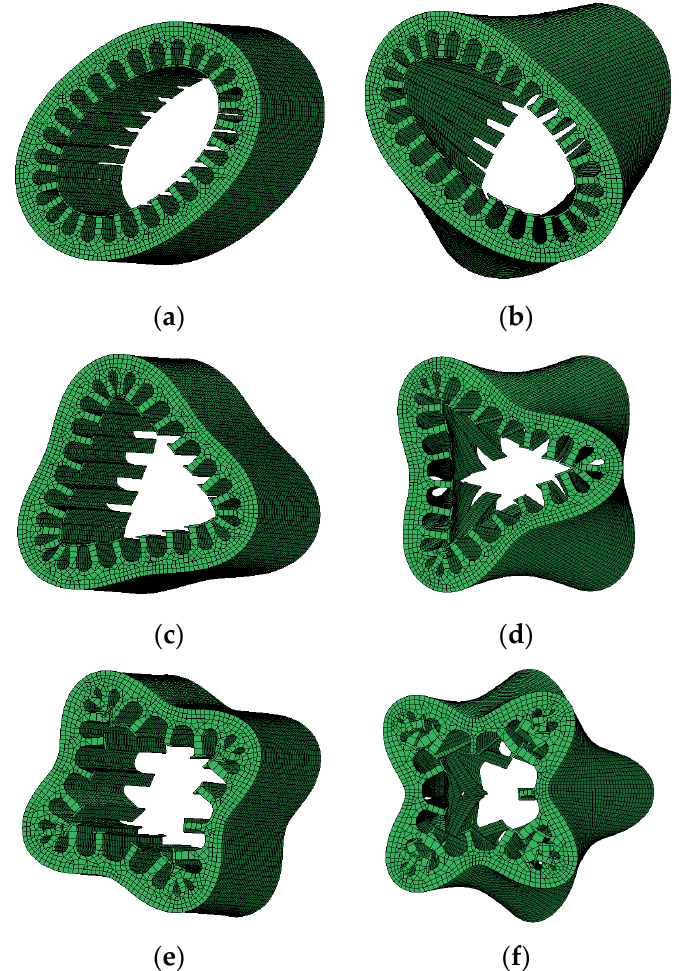
Figure 1. Normal modes of stator’s structure: ( a , b ) first mode — 928 Hz; ( c , d ) second mode — 2485 Hz; ( e , f ) fourth mode — 4433 Hz .